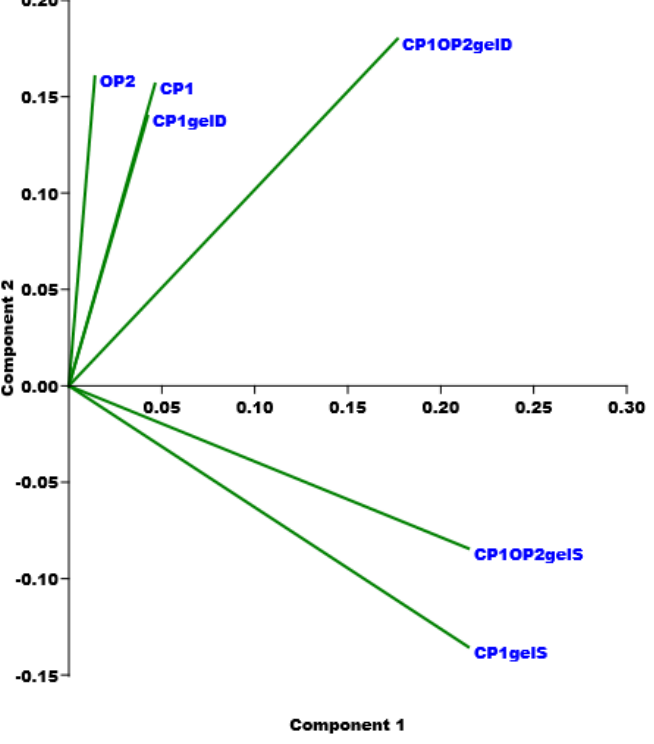
Figure 7. Results represented as a score plot by PCAs performed on the matrix collecting spectral data of CP1, OP2, swollen and dry CP1-based gel, as well as of swollen and dry CP1OP2-based gel developed here (PC1 vs. PC2).